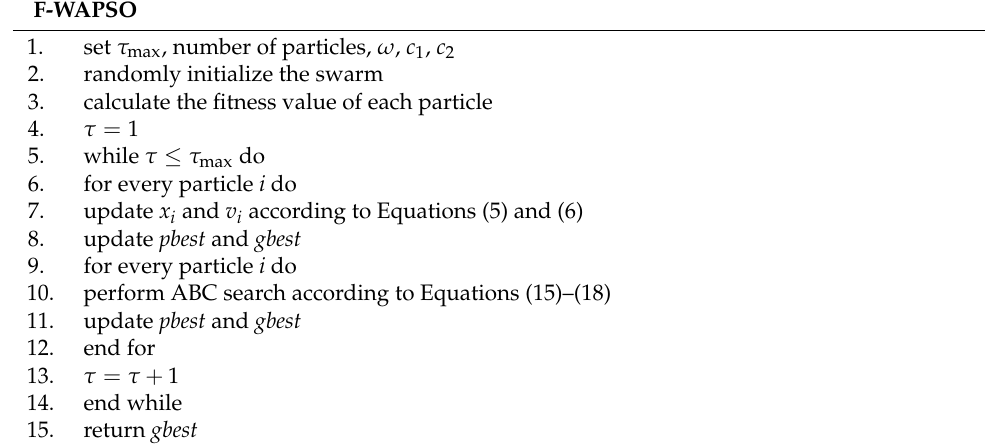
Table 2. The pseudocode of